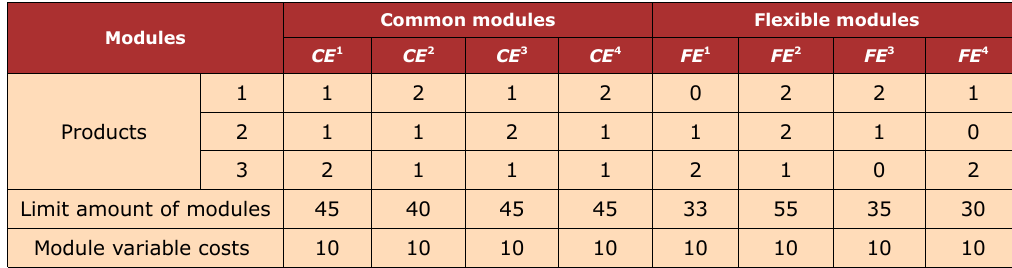
Table 2. Internal module structure, limit amount and costs for product 1, 2,